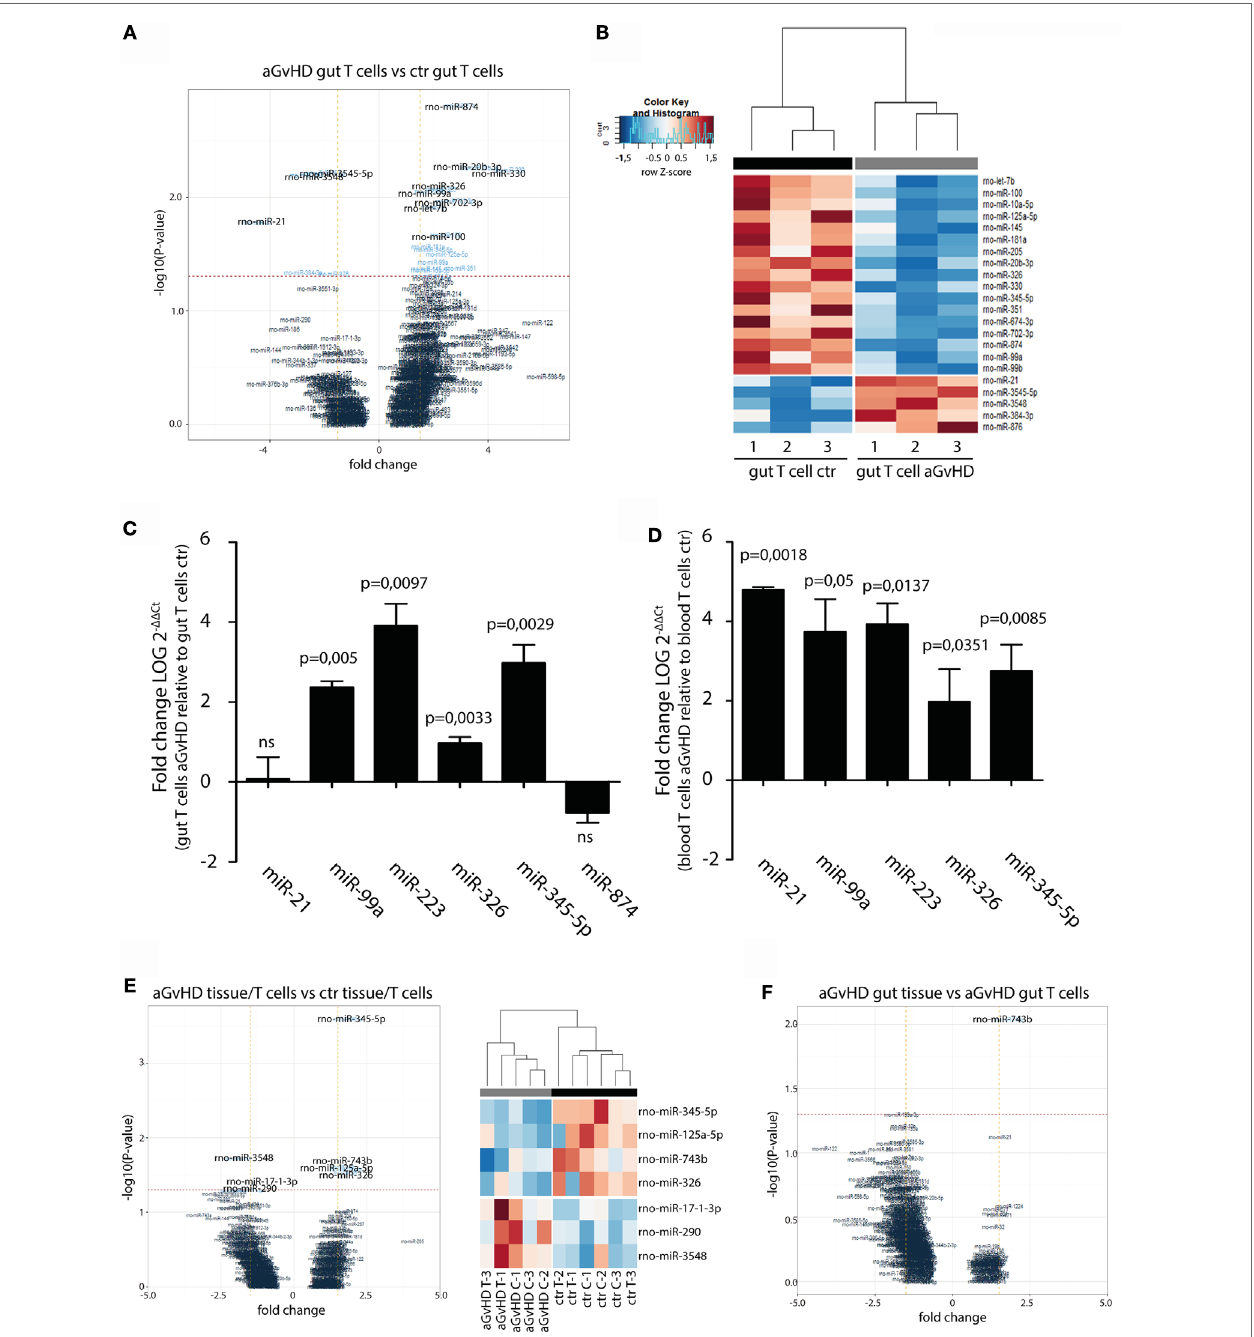
FigUre 6 | mirna expression in intestinal T cells and comparison to intestinal tissues . (a) Volcano plot showing the relationship between fold change and significance between the two groups. The horizontal dashed line indicates cutoff for significance p < 0.05 ( − log10 p -value > 1.3) and the vertical lines for fold change ≥ 1.5/ ≤− 1.5. (B) Heatmap showing unsupervised hierarchical clustering of differentially expressed miRNAs in intestinal T cells between control ( n = 3) and aGvHD ( n = 3) animals. Each column represents an individual rat. Relative fold change is indicated by the color scale (red: high; blue: low). (c) qRT-PCR analysis of miRNA expression in intestinal T cells from control ( n = 3) or aGvHD ( n = 3) rats. Samples were normalized to endogenous controls and expression levels reported as log of 2 −ΔΔ Ct ± SD. Significance was calculated using the Student’s t -test (two-tailed) with Welch’s correction. (D) qRT-PCR analysis of miRNA expression in peripheral blood T cells from control ( n = 3) or aGvHD ( n = 3) rats. Samples were normalized to endogenous controls and expression levels reported as log of 2 −ΔΔ Ct ± SD. Significance was calculated using the Student’s t -test (two-tailed) with Welch’s correction. (e) Volcano plot (left panel) and heatmap (right panel) showing differentially expressed miRNAs in intestinal T cells (C) and intestinal tissue (T) from aGvHD rats compared to intestinal T cells (C) and intestinal tissue (T) from controls. (F) Volcano plot showing the relationship between fold change and significance between the intestinal tissue and intestinal T cells from aGvHD rats. The horizontal dashed line indicates cutoff for significance p < 0.05 ( − log10 p -value > 1.3) and the vertical lines for fold change ≥ 1.5/ ≤− 1.5.